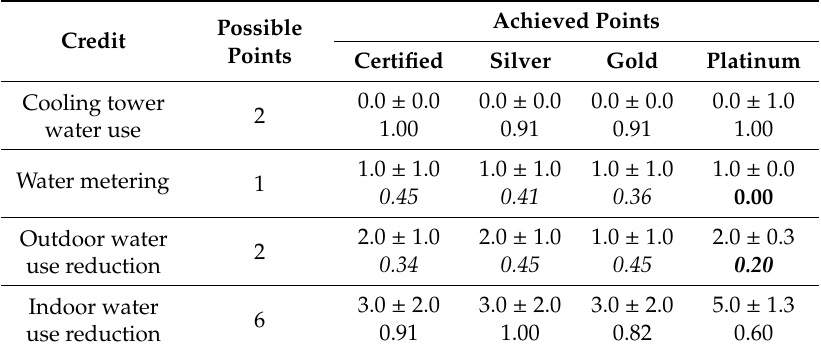
Table 4. Credit points achieved for Water E ffi ciency category of LEED-NCv4 projects: median ± IQR (25th–75th) and Cli ff ’s δ e ff ect size between possible and achieved points in a credit.